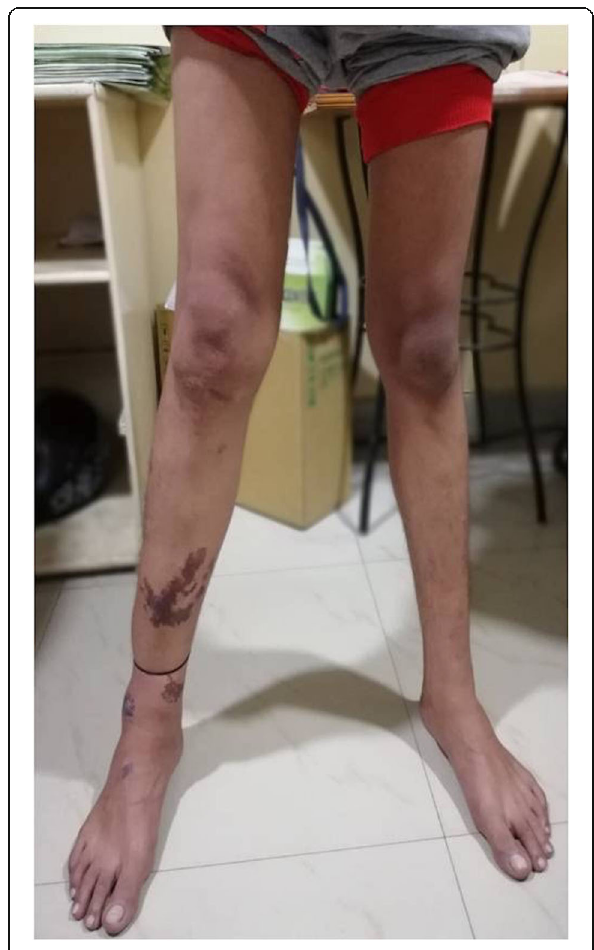
Fig. 4 Clinical photograph of the patient (case 3) showing hypertrophied right lower limb with multiple cutaneous macular lesions in the right